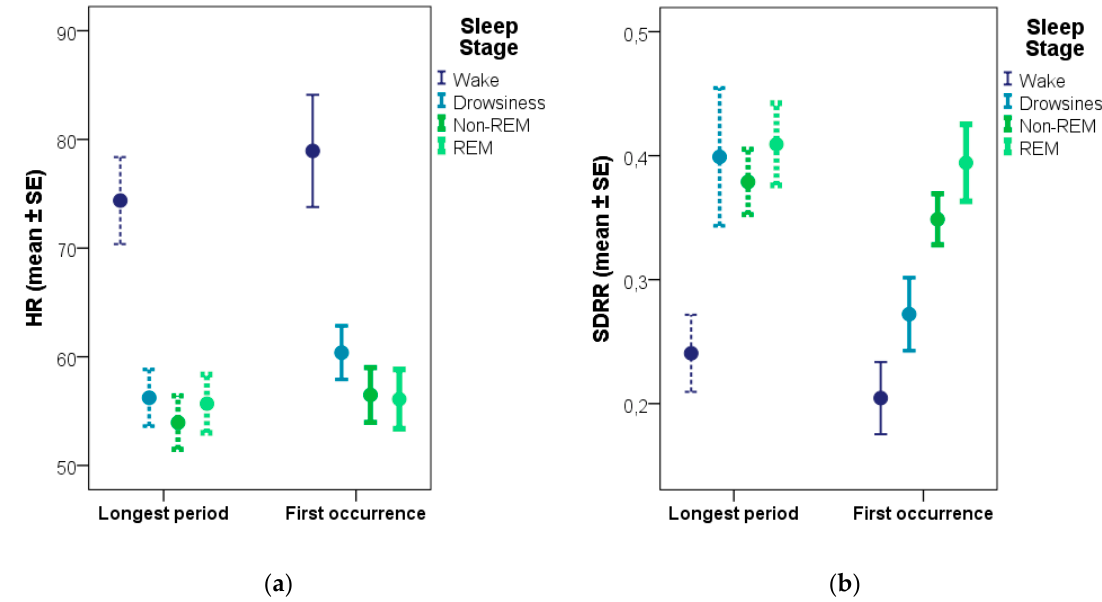
Figure 2. Differences between sleep and awake stages based on the longest period versus the first occurrence of the given stage regarding heart rate ( a ) and SDRR, a heart rate variability measure ( b ).